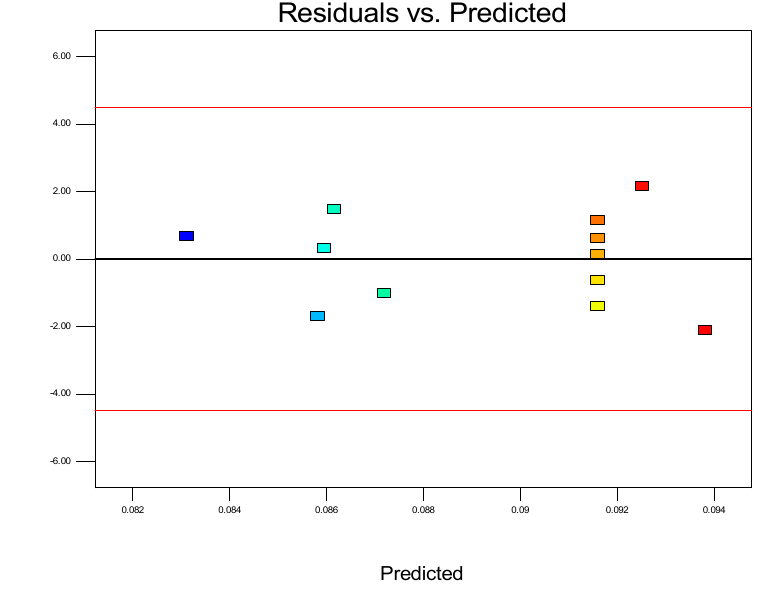
Figure 5. The residuals vs. predicted COF for the MoS 2 nanolubricants.